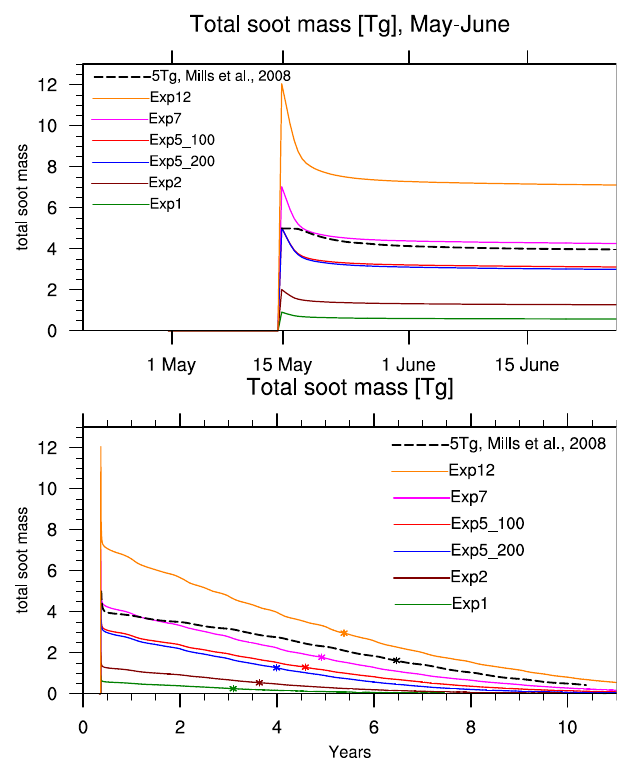
Fig. 1. Temporal evolution of the total mass of atmospheric soot for different amounts of soot initially emitted into the upper tropo- sphere. The dashed black line indicates the results of Mills et al. (2008). The other lines show SOCOL results, including radiative feedback. Upper panel: first 45 days after soot emission. Lower panel: 11yr of simulation. The mass e-folding time of the atmo- spheric soot burden after the initial wash-out is indicated by